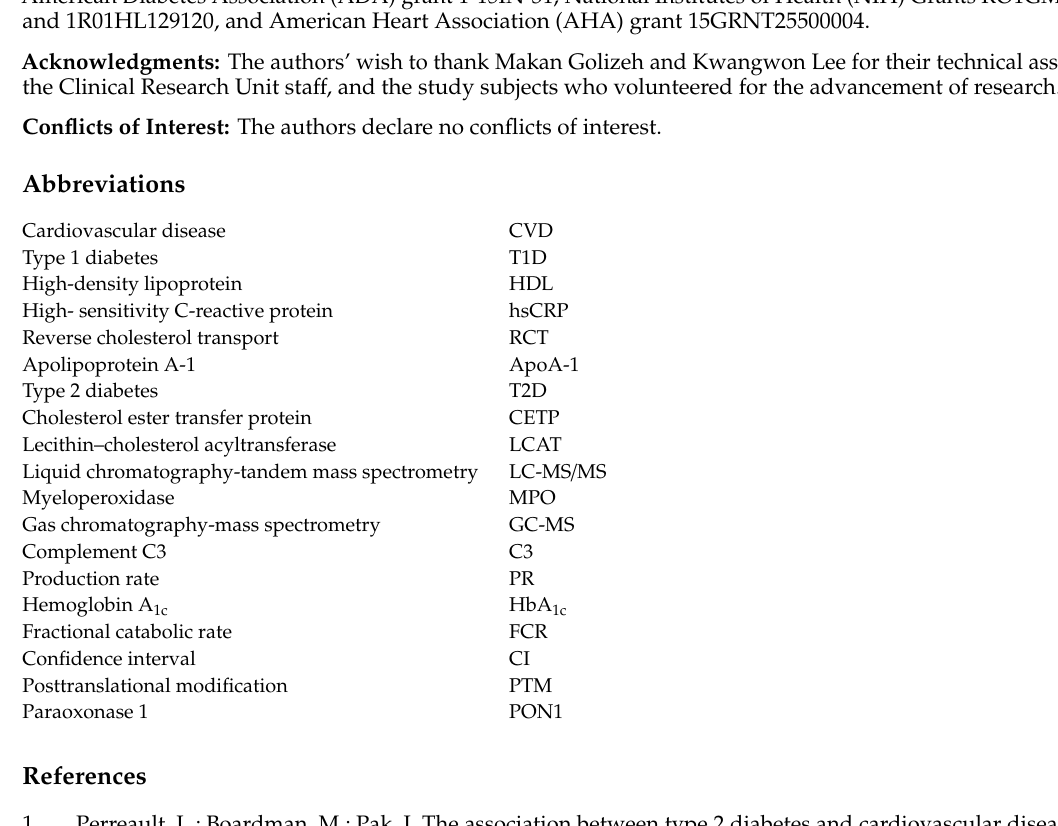
Table S1: List of the identified proteins in HDL isolated by anti-HDL immunoa ffi nity method in healthy controls and T2D patients (n = 8 / group), Table S2: Comparison of the half-lives of HDL proteins in healthy controls and T2D patients isolated by anti-HDL immunocapture and ApoB-depletion